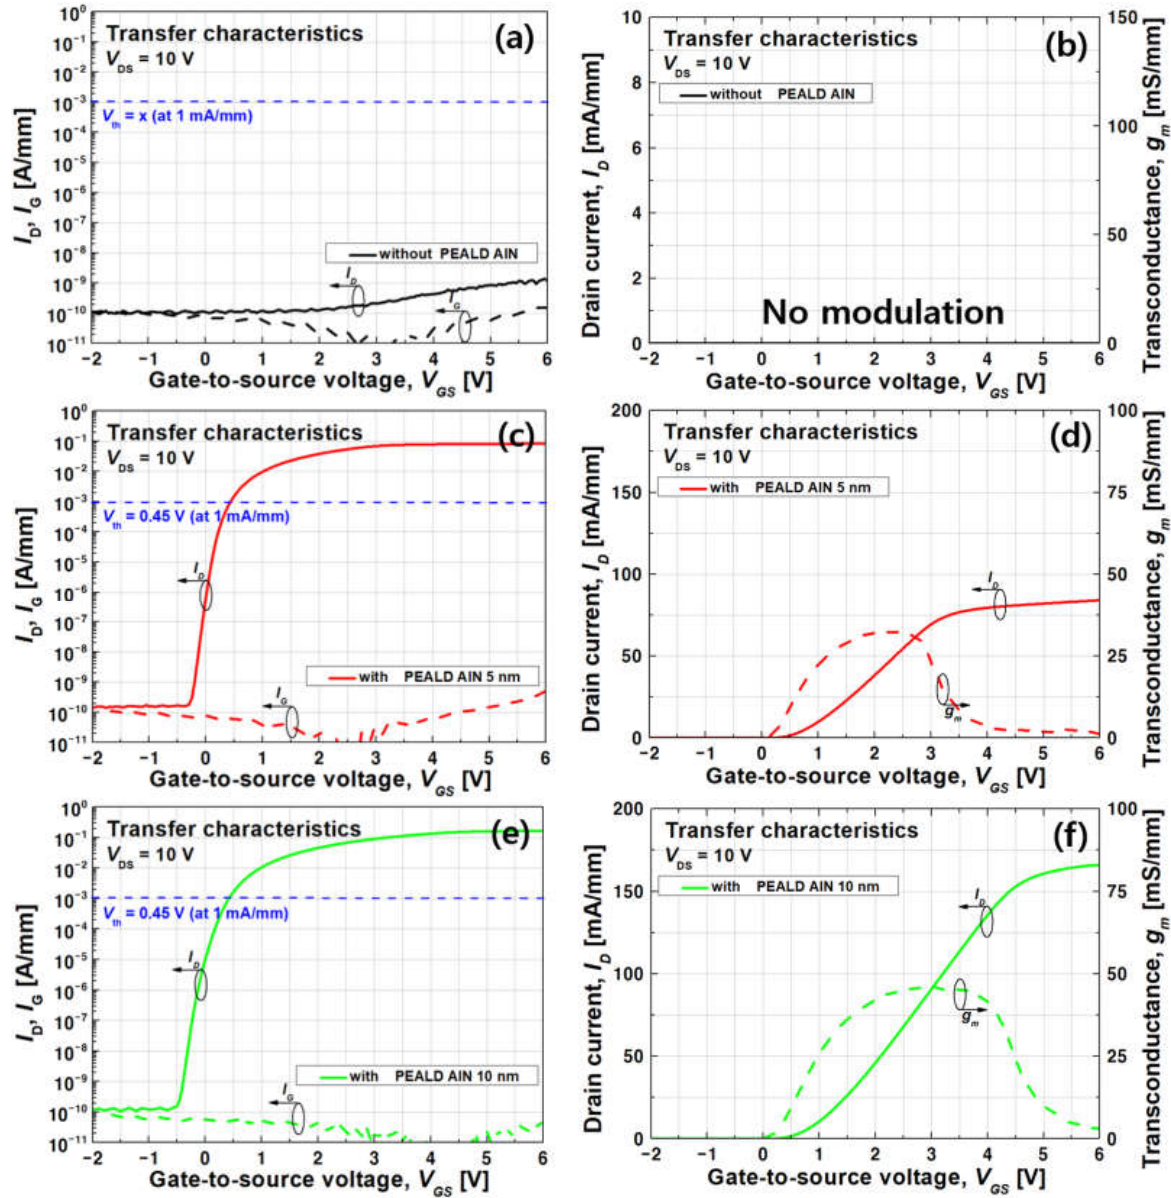
Figure 8. Transfer characteristics of fabricated thin-AlGaN/GaN MIS-HFETs; ( a , b ) reference device without PEALD AlN film, ( c , d ) device with a 5 nm thick PEALD AlN film, and ( e , f ) device with a 10 nm thick PEALD AlN film.